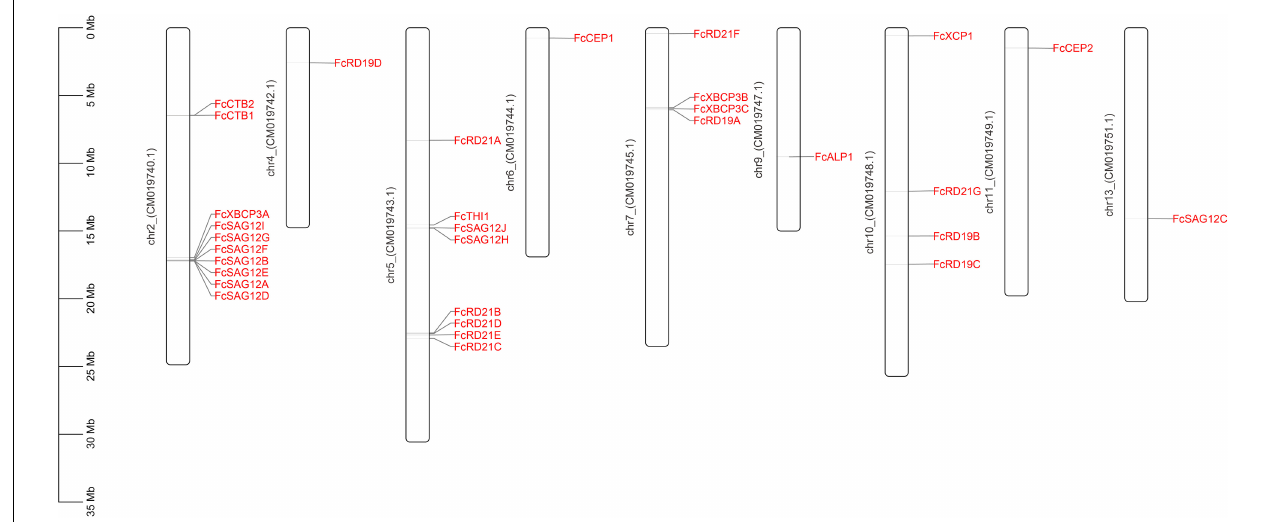
FIGURE 1 | Chromosomal location of 31 FcPLCP genes. The chromosome number is marked on the left side of the